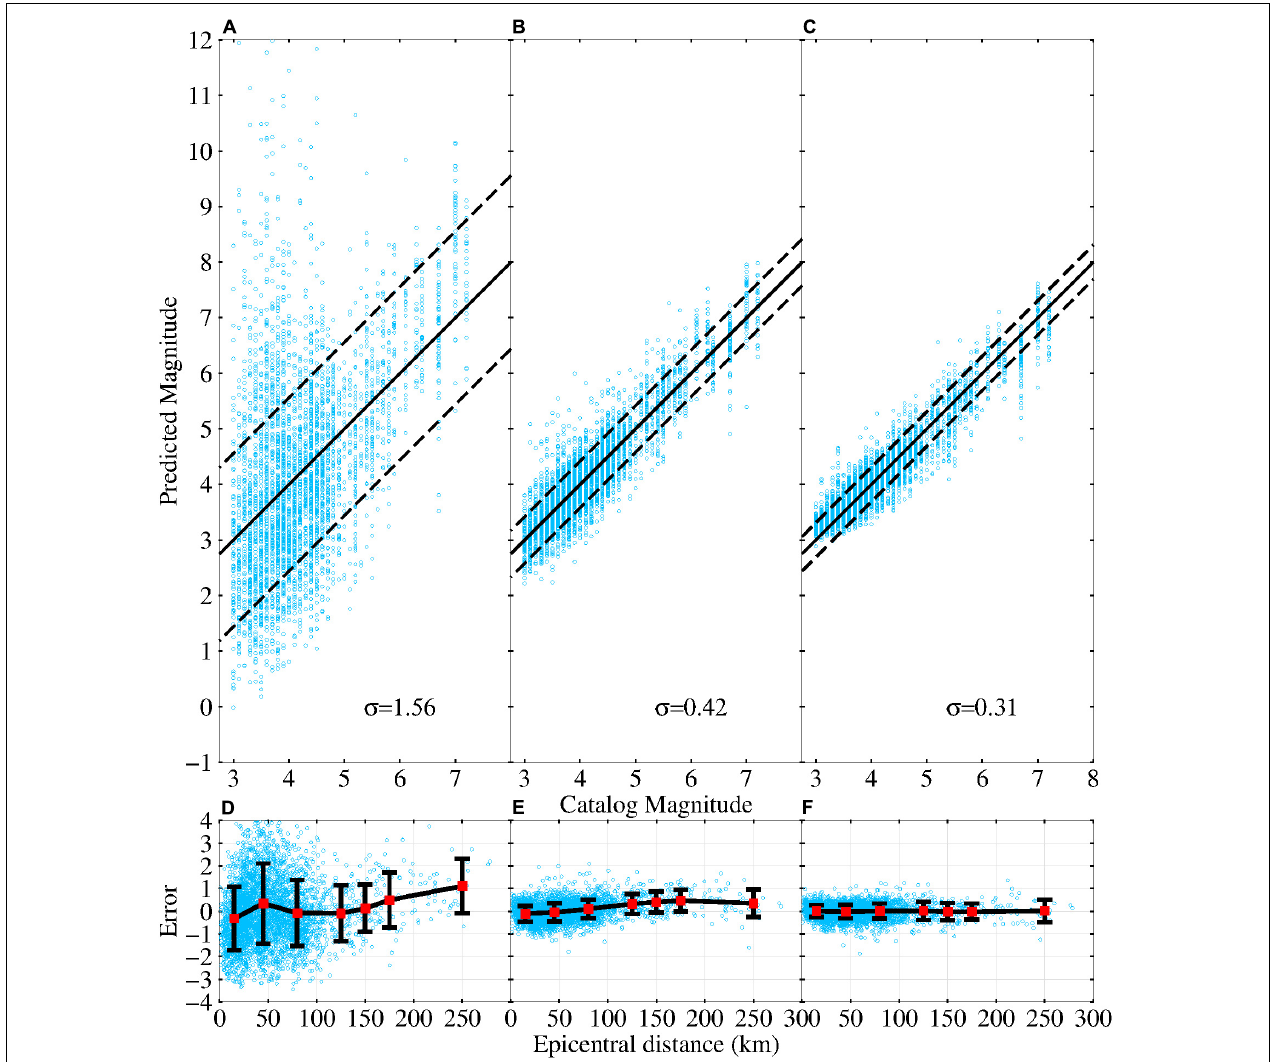
FIGURE 5 | Catalog magnitudes versus predicted magnitudes produced using the test dataset by (A) the τ c method, (B) the P d method, and (C) the DCNN-M model. On the solid black 45 ◦ line, the predicted magnitude is equal to the catalog magnitude. The two black dashed lines indicate the locations of one standard deviation of error. The relationship between the epicentral distance and the error in the predicted magnitude for (D) the τ c method, (E) the P d method, and (F) the DCNN-M model. The epicentral distance is divided into seven sections: (0 km, 30 km), (30 km, 60 km), (60 km, 100 km), (100 km, 150 km), (125 km, 175 km), (150 km, 200 km), and (200 km, 200+ km). The position of the solid red square represents the mean of the errors within an epicentral distance. The length of the black bar shows the standard deviation of the magnitude estimation errors within an epicentral distance, which reflects the discreteness of the